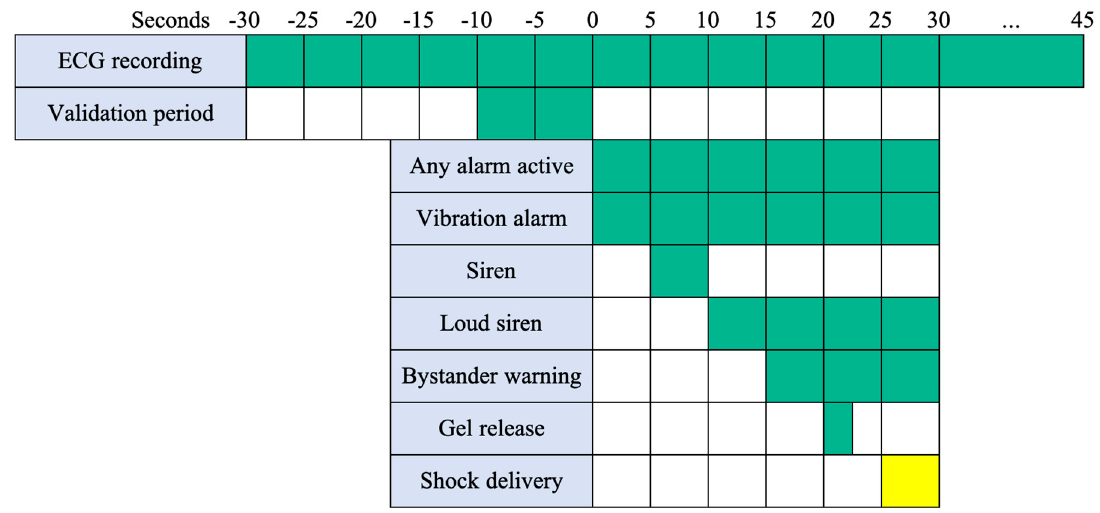
Figure 1. Alarms and treatment sequences. The timing of alarm sequences and delivery of shock depicted in five seconds steps. Figure is adapted from ZOLL.